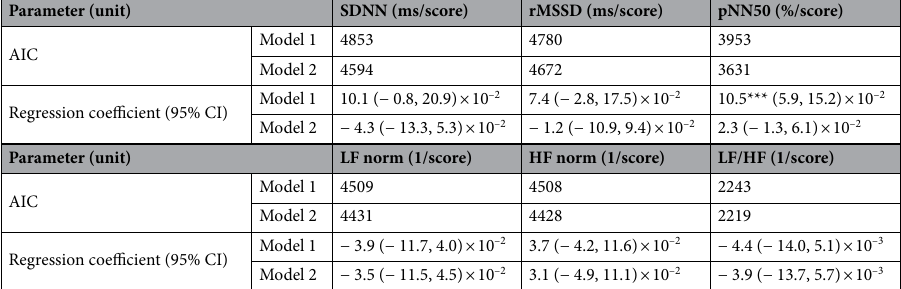
Table 3. Comparison of Akaike’s information criterion and regression coefficients between the two models for heart rate variability parameters. AIC Akaike’s information criterion, CI confidence interval, HF norm normalised values of high-frequency heart rate variability, LF norm normalised values of low-frequency, numeric rating scale, pNN50 percentage of adjacent N–N intervals that differ from each other by > 50 ms, rMSSD root mean square of successive normal-to-normal interval differences, SDNN standard deviation of normal normal-to-normal intervals. * p < 0.05; ** p < 0.01; *** p < 0.001.